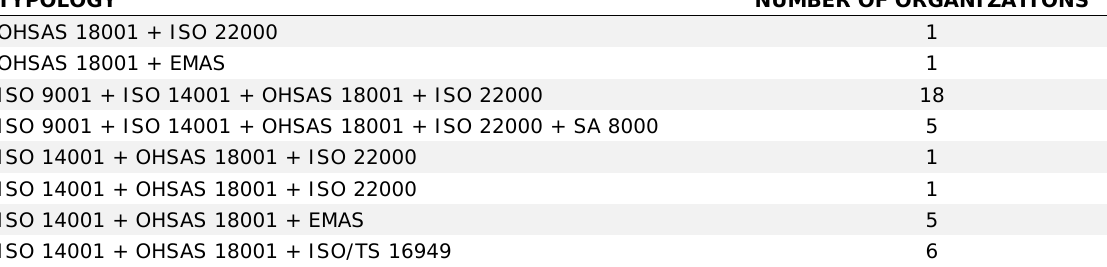
Table 2. Other integrated typologies encompassing the OHSMS. TYPOLOGY NUMBER OF